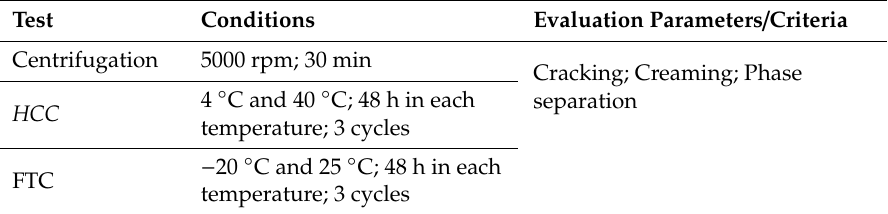
Table 5. Details of the thermodynamic stability